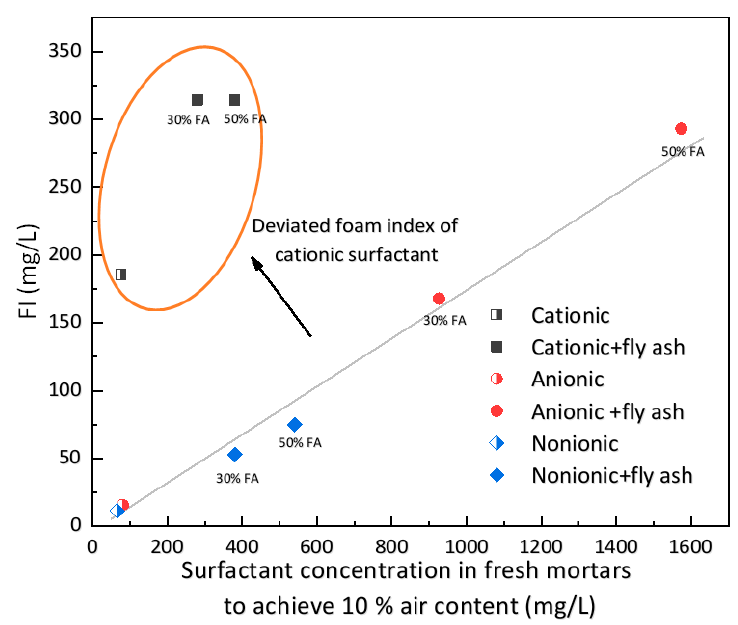
Figure 5. Influence of the type of surfactant on foam index (FI) and surfactant concentrations in fresh mortars to achieve 10% air content with or without fly ash. Materials 2020 , 13 , x FOR PEER REVIEW